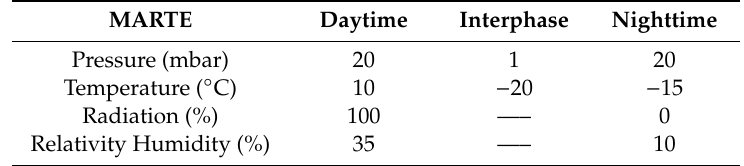
Table 3. MARTE’s range of environmental variables during hydrological cycle